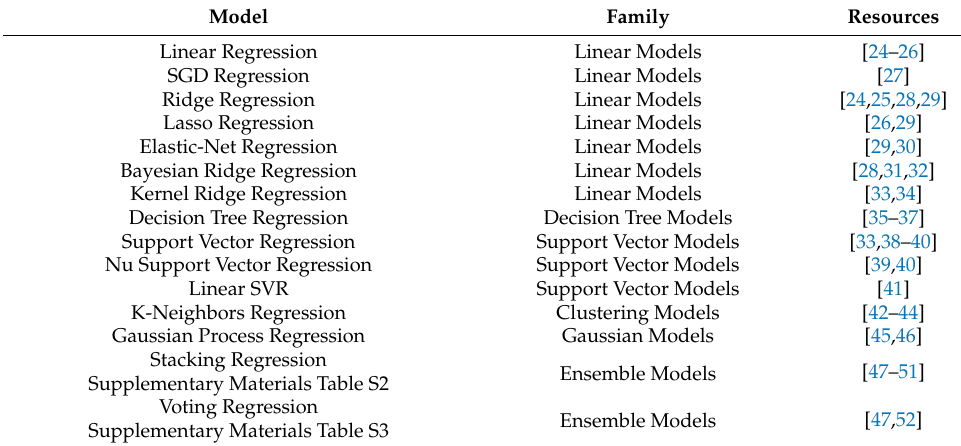
Table 2. We display each model used in the case study. The model is given first, followed by which family grouping the model fits in. Relevant resources are listed for further reading and